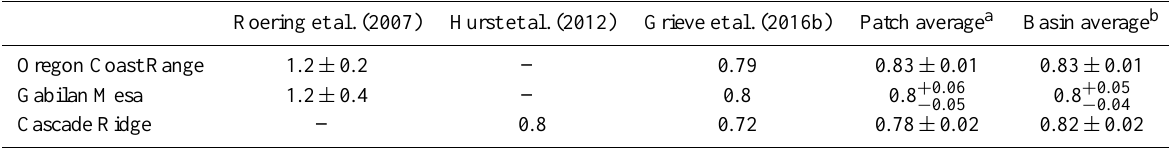
Table 1. Previously published S c values alongside the values generated from the best fit to the steady-state curve for the patch and basin average data.